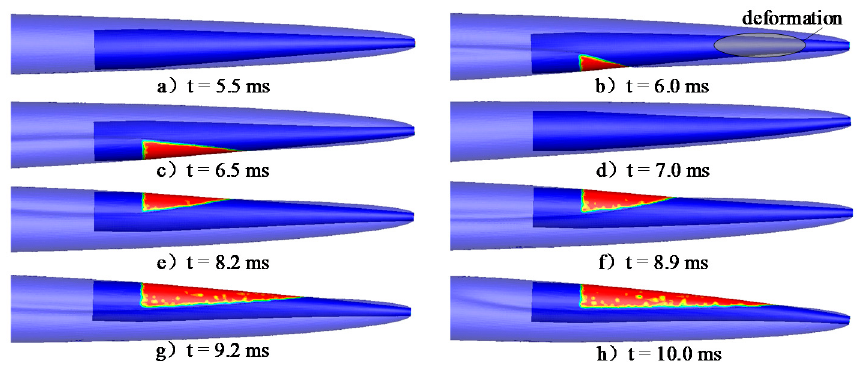
Figure 9. Deformation of supercavitating projectile and wetted status in amplitude amplification stage.